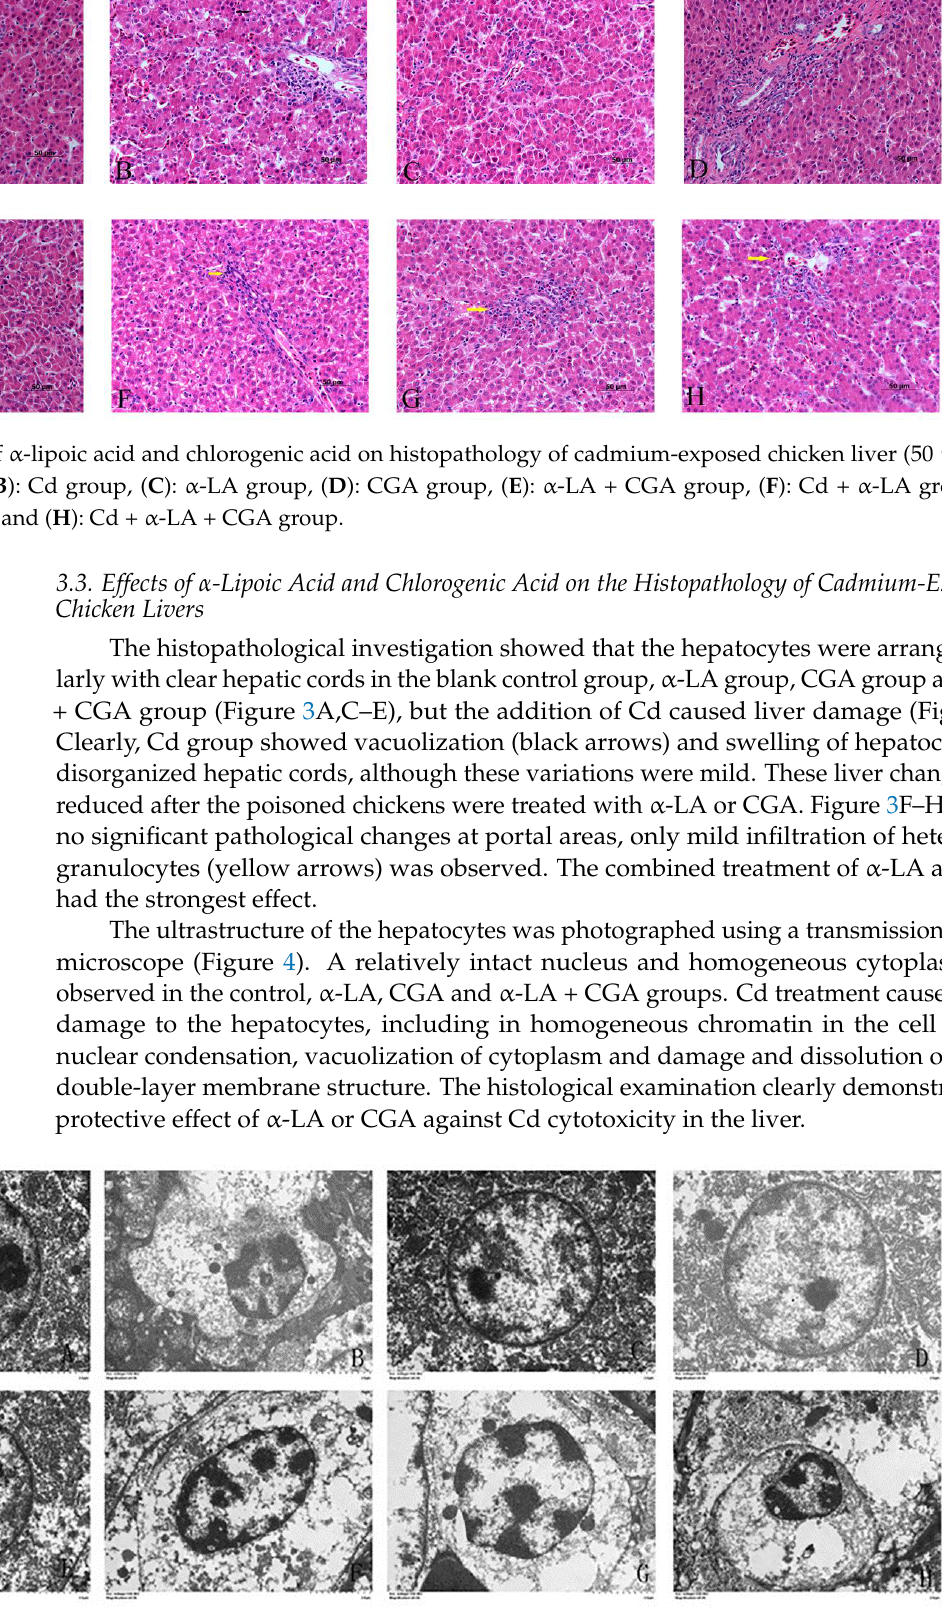
Figure 4. The effect of α -lipoic acid and chlorogenic acid on the nuclei of hepatocytes in cadmium-exposed chickens (6000×). ( A ): Control group, ( B ): Cd group, ( C ): α -LA group, ( D ): CGA group, ( E ): α -LA + CGA group, ( F ): Cd + α -LA group, ( G ): Cd + CGA group and ( H ): Cd + α -LA + CGA group.